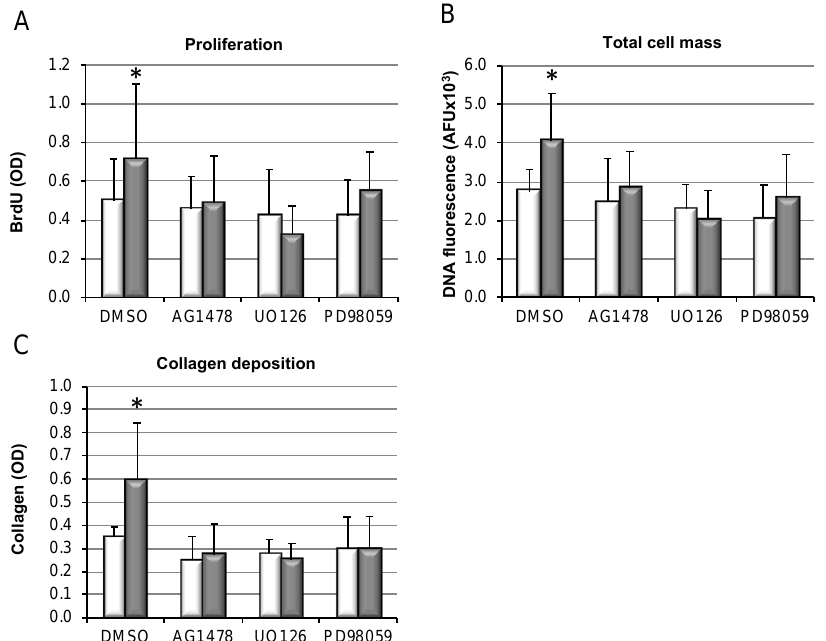
Figure 6. Inhibition of the EGFR / MEK signaling pathway prevents bile-salt-induced proliferation, cell accumulation, and collagen deposition by HSC. HSC were isolated from wildtype mice and stimulated with 250 µ M CDCA (grey bars) or DMSO as control (white bars). Cells were co-incubated with DMSO as control or 10 µ M AG1478, 10 µ M UO126, and 50 µ M PD98059, respectively. DNA incorporation was determined after 7 days of culture ( A ). Following a total culture period of 14 days, DNA fluorescence